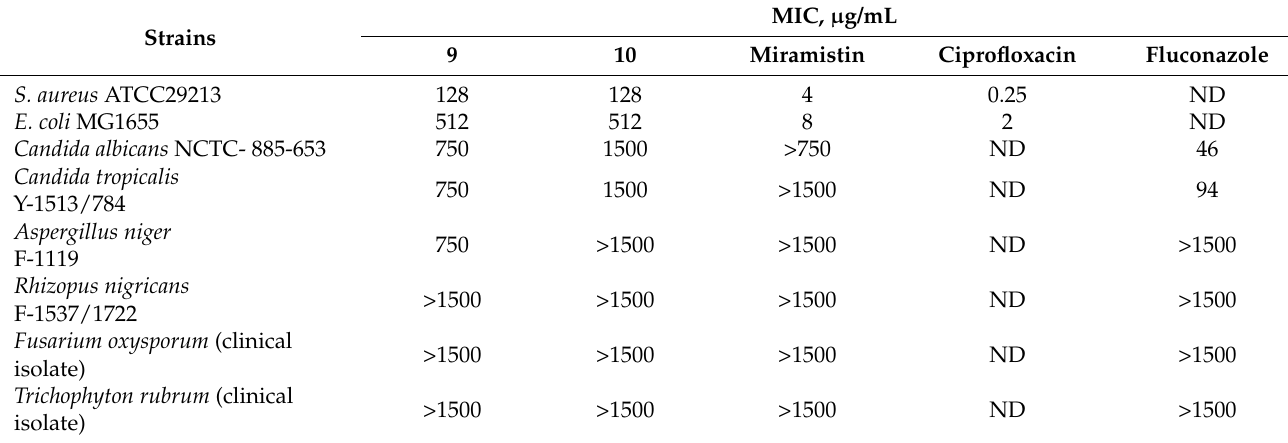
Table 1. Antibacterial and antifungal activities of 9 and 10